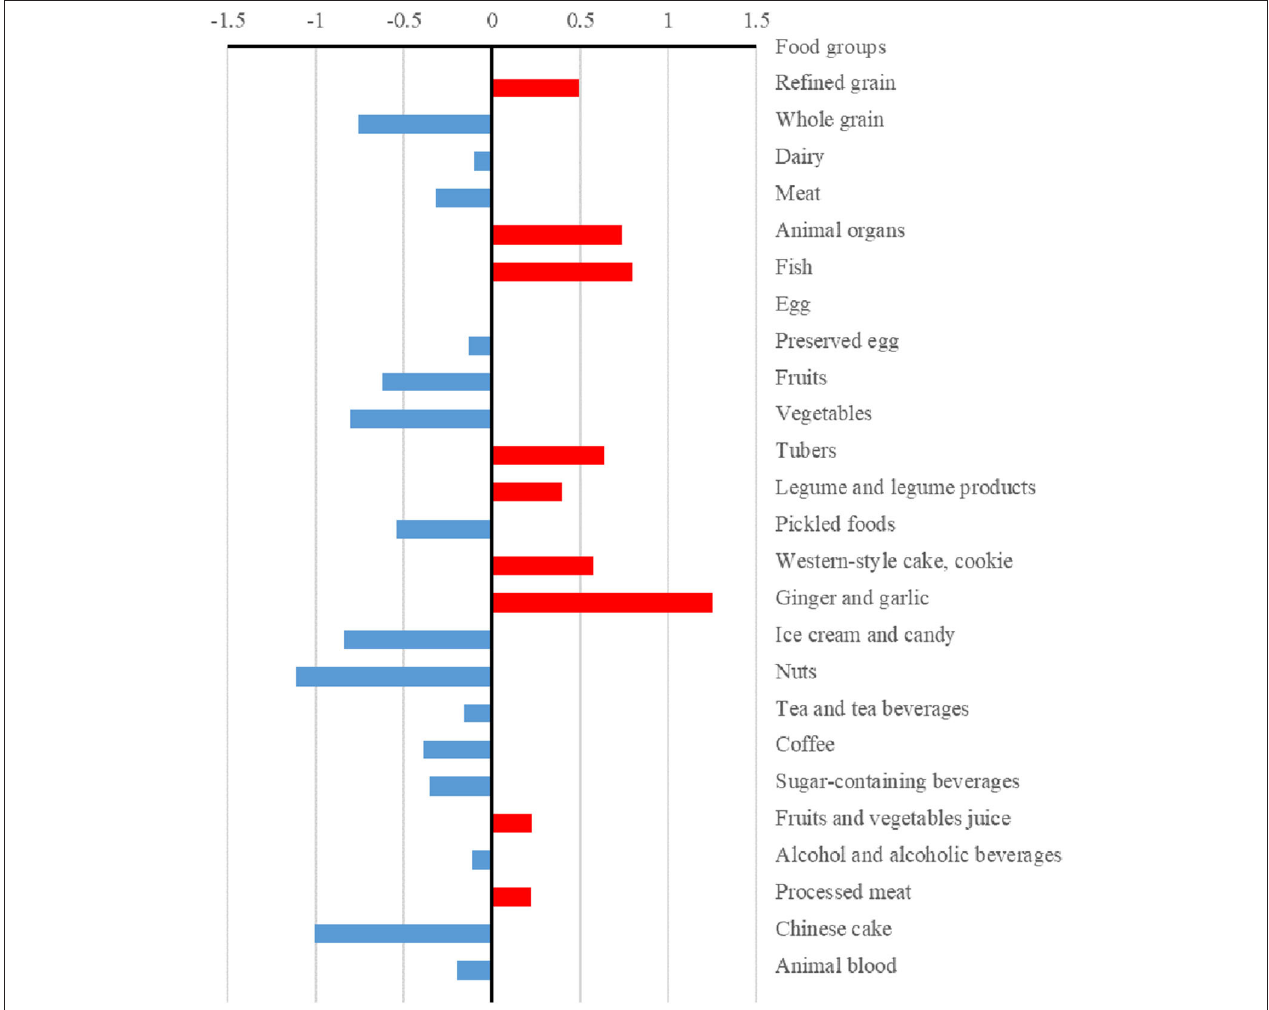
FIGURE 3 | Differences in the strengths of food groups between case and control dietary topologies. For each node, strength was computed as the sum of edge weights (mutual information) associated with other nodes, which represented the direct associations between each node and others. The differences in strengths of food nodes calculated by subtracting control values from case